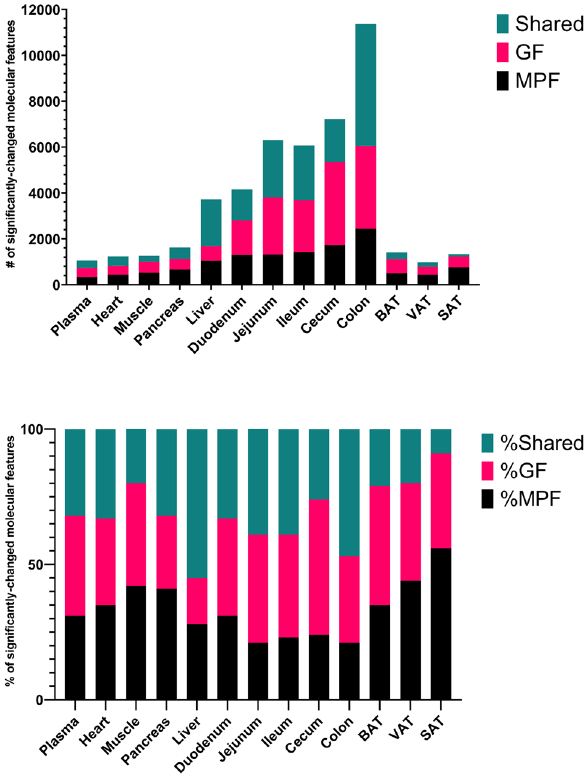
Figure 1. Number and percentage of significant molecular features per tissue. The total number of total significant molecular features from each tissue sourced from MPF only, GF only or shared (upper), Percentage of significant unique molecular features from each murine class per tissue (lower). Level of significance is defined as having a fold change ≥ 1.3, p value ≤ 0.05, and q value ≤